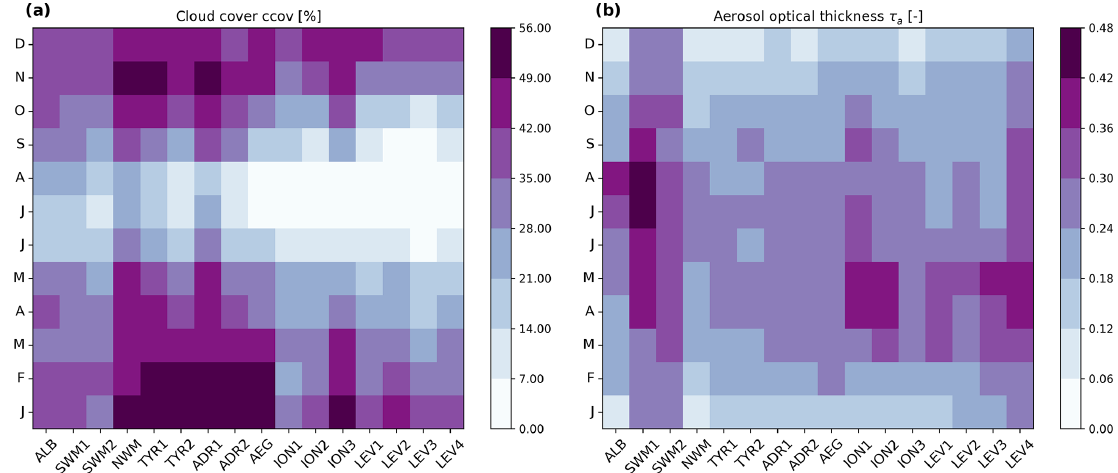
Figure 5. ERA-Interim data of the cloud cover (a) and MODIS aerosol optical thickness at 475nm (b) , aggregated spatiotemporally based on the climatological months ( y axis) and in the 16 sub-basins ( x axis), as shown in Fig. 2.